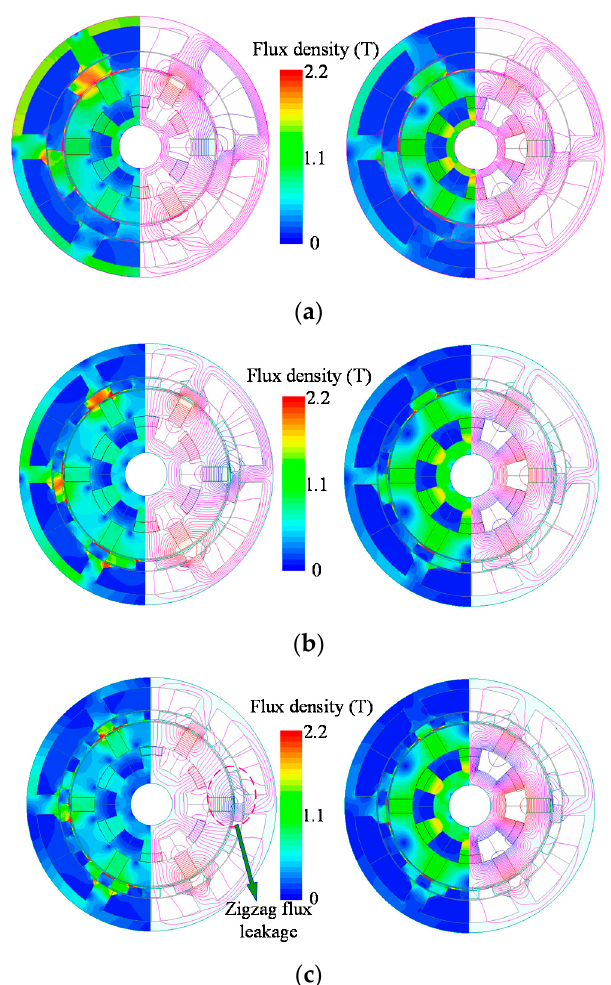
Figure 5. Topologies and field plots of the 6-stator slot machines having various selected rotor pole